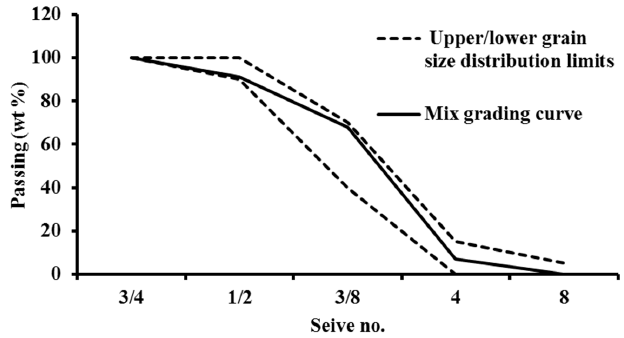
Figure 2. Pattern of grading curve for combined fine aggregate.